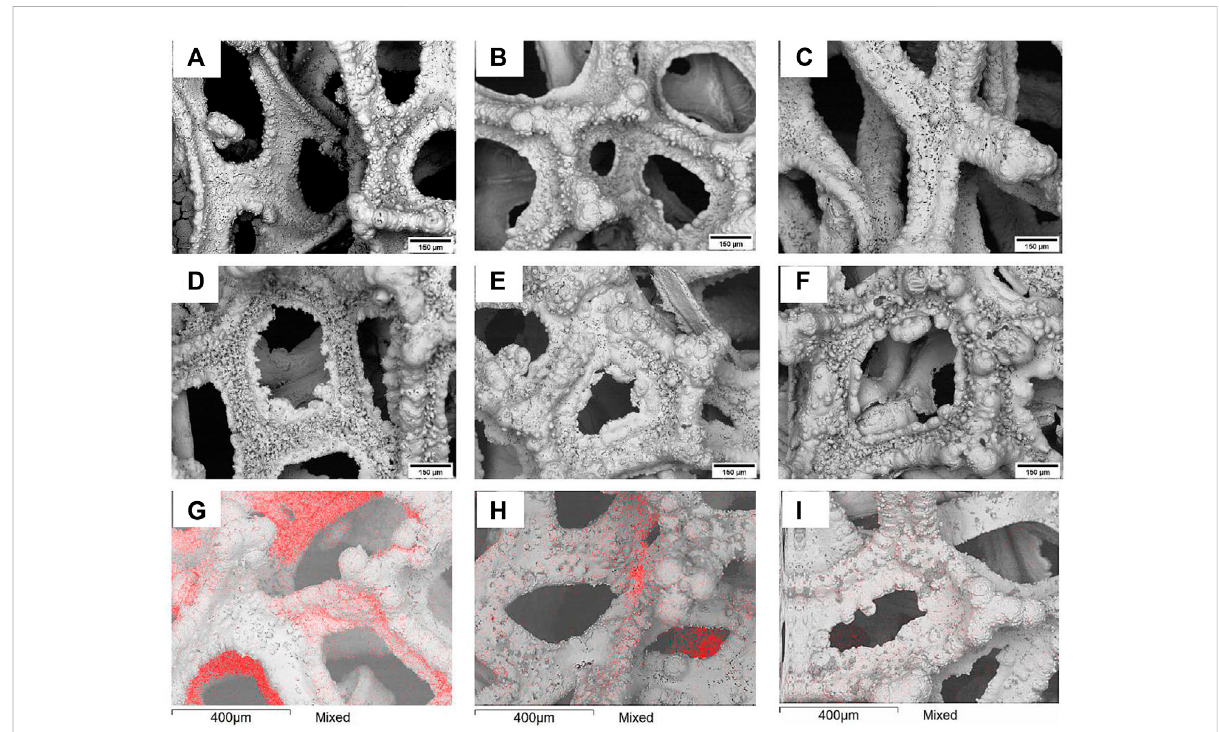
FIGURE 2 SEM images of electrochemically deposited copper under different conditions: top row q = 450 C (A) − 1.5 V, (B) − 1.7 V (C) − 1.9 V; middle row — E= − 1.9 V (D) q=150 C, (E) q=900 C, (F) q=1350 C;bottomrow — SEM/EDSmapanalysis,wheretheredcolorontheimagesindicatestheCu distribution at (G) 150 C, (H) 300 C, (I) 450 (C) .